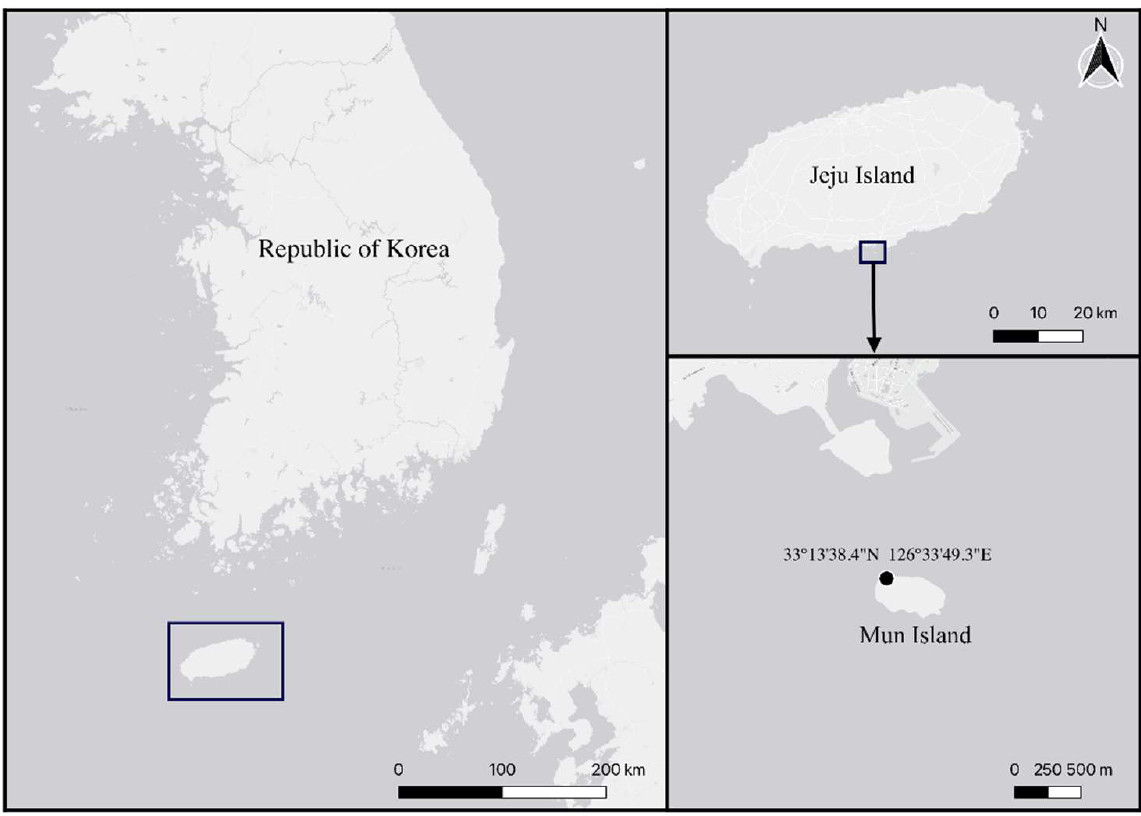
Figure 1. Map of sample locality.